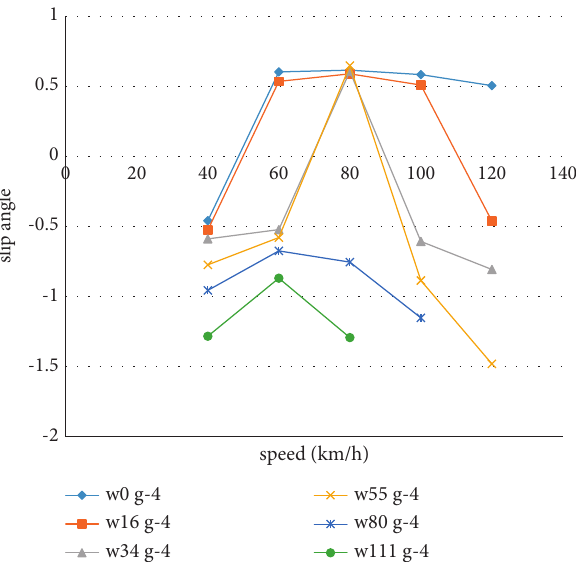
Figure 23: Comparison of maximum slip angle values in terms of vehicle speed.